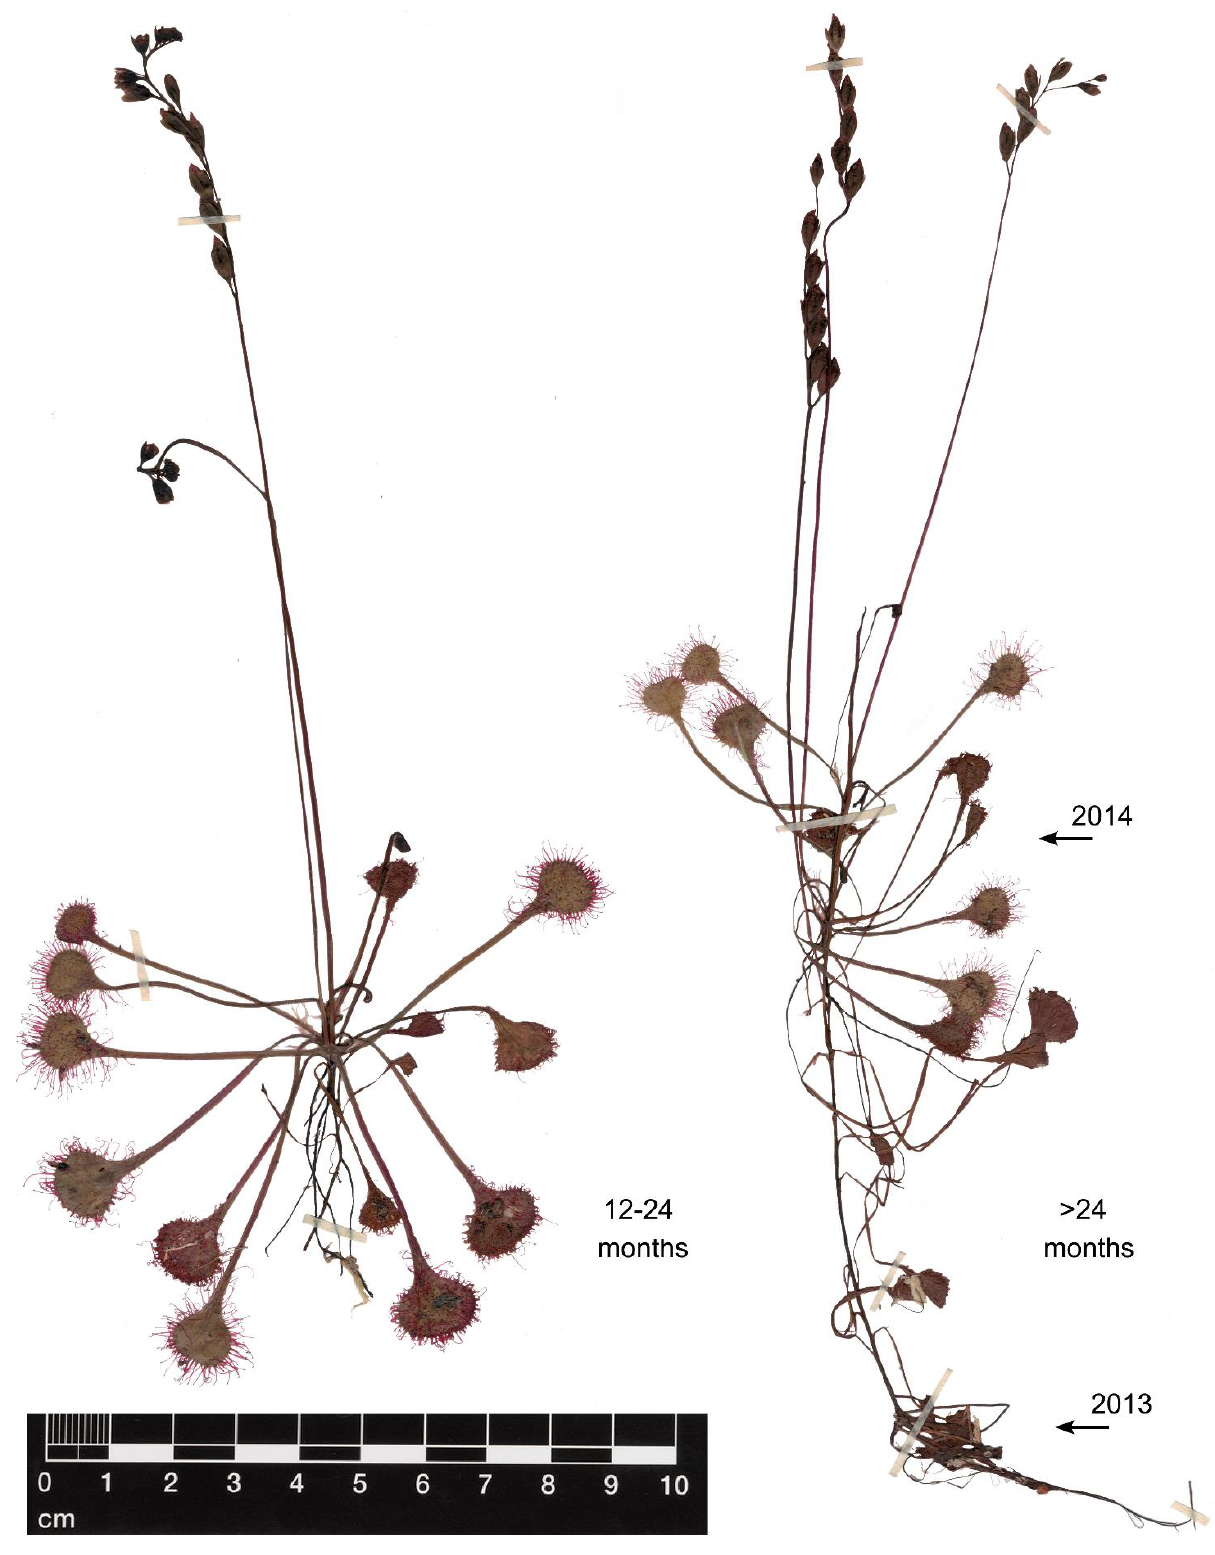
Figure A3. Drosera rotundifolia plants of ages 12–24 and >24 months, the latter with rosettes from the previous year (2013) and the year of collection (2014). Collected on the Sphagnum palustre field of the Sphagnum farm in Rastede (north-west Germany). Collected and determined by Balázs Baranyai, 17 August